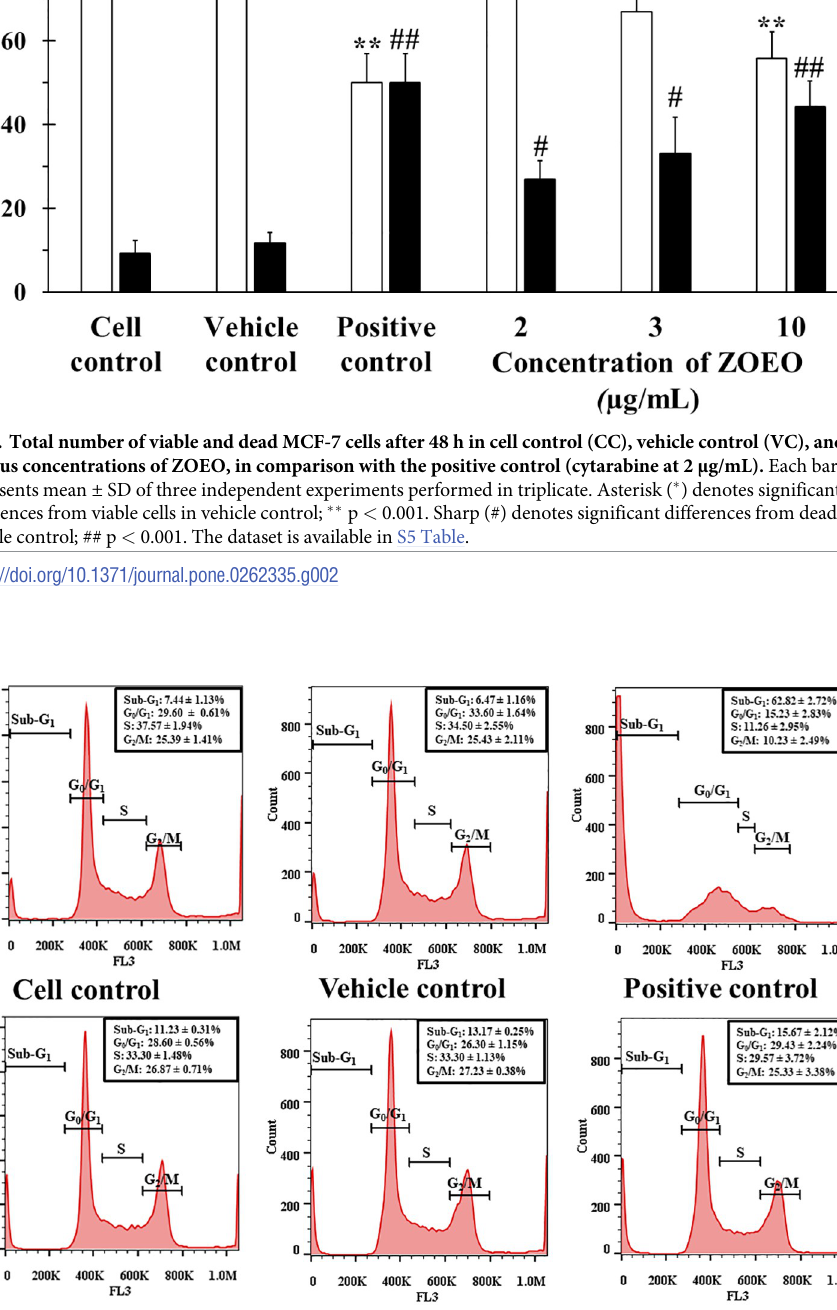
PLOS ONE | https://doi.org/10.1371/journal.pone.0262335 January 24,